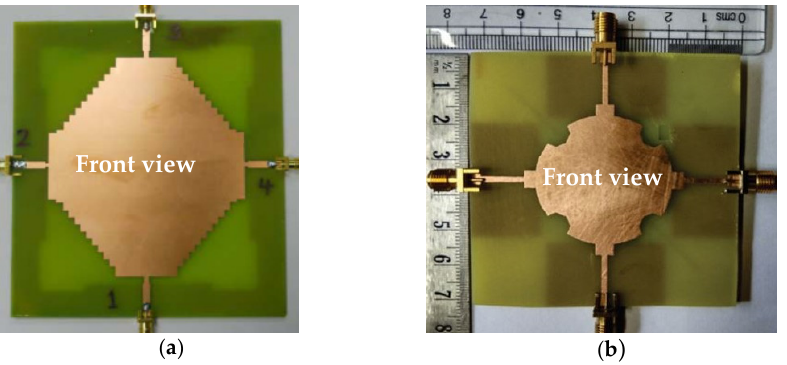
Figure 17. ( a ) Stepped line common radiator prototype [80], ( b ) Notch-loaded circular radiator [81].